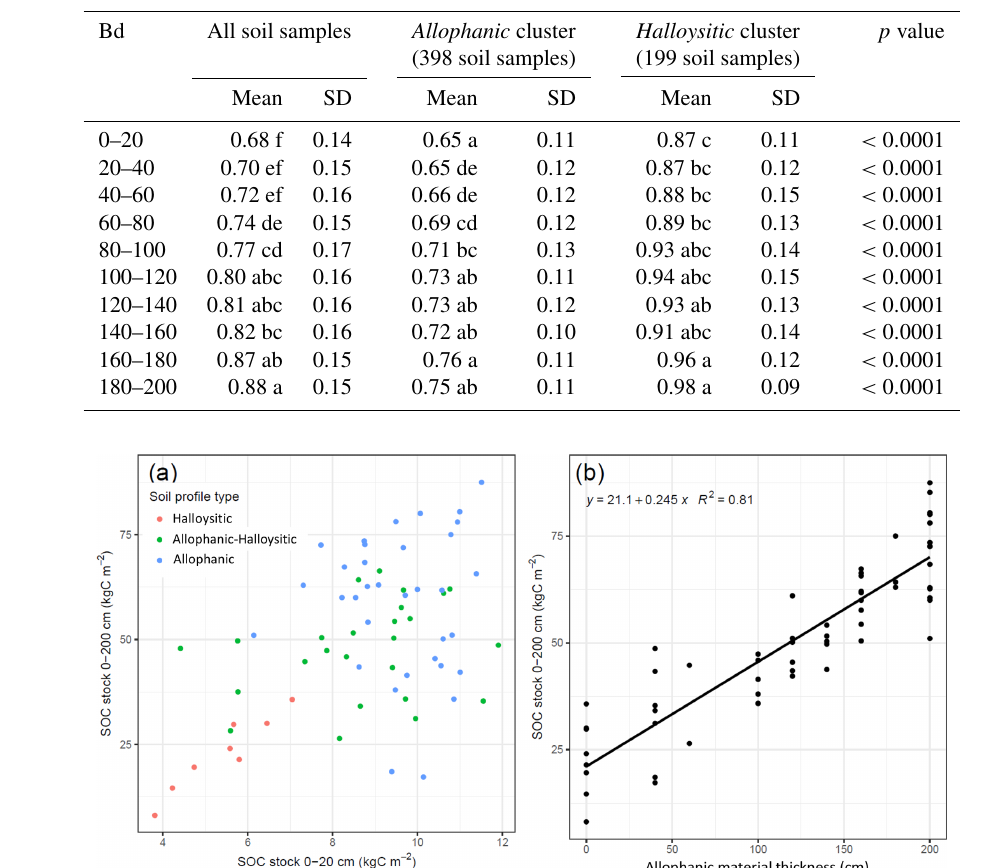
Figure 8. Relationship between the SOC stock at 0–200cm depth and (a) the SOC stock at 0–20cm depth; (b) the thickness of the allophanic soil